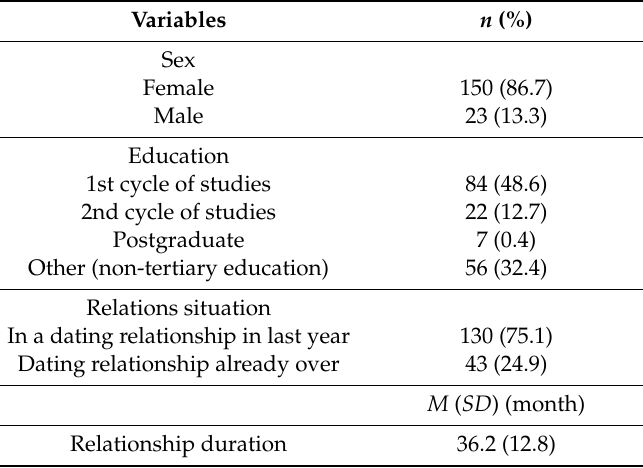
Table 1. Participants’ characteristics ( n =